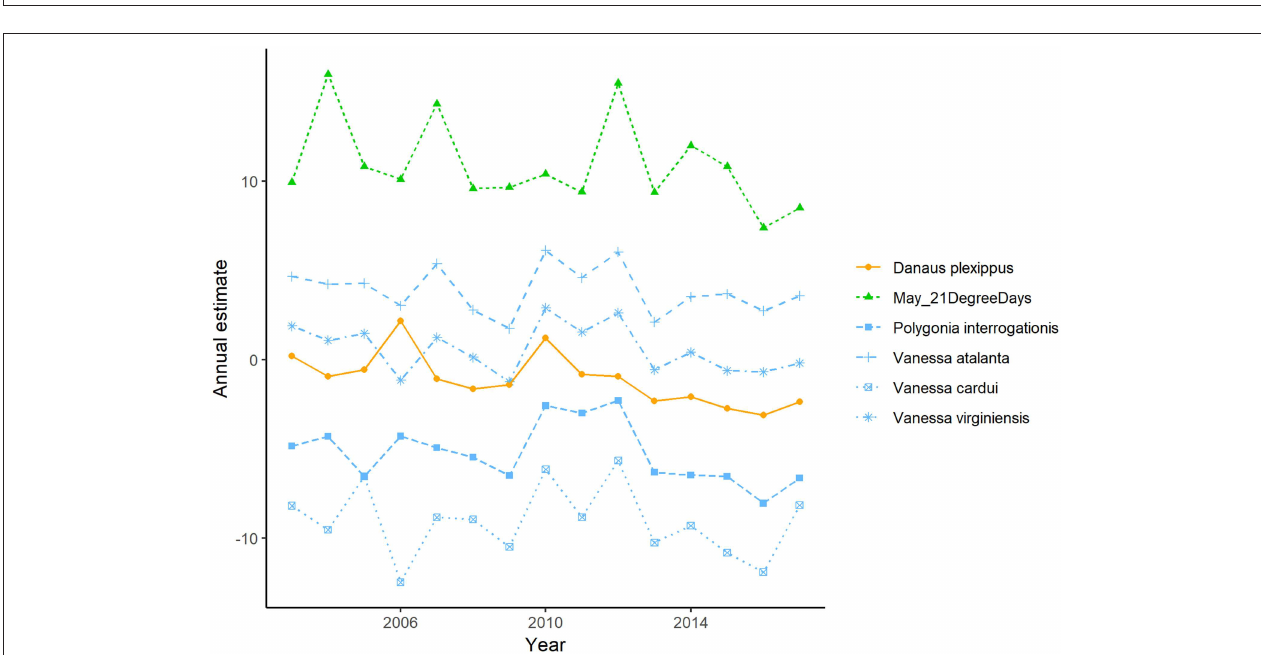
FIGURE 7 | Detrended annual indices for migrant butterflies that breed in southern Canada plotted with the detrended mean number of 21 ◦ days in May in the mid-eastern United States. Significant correlations between detrended breeding annual indices and detrended mean 21 ◦ days were not detected, though proportion of corresponding maxima and minima ranged between 0.60 and